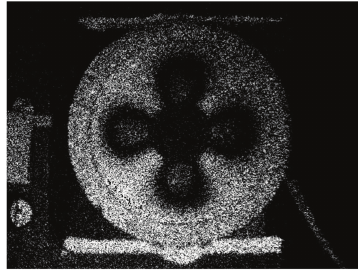
Figure 11: Hologram of B 12 modal shape of the actuator with asymmetric waveguide (53.2 kHz).